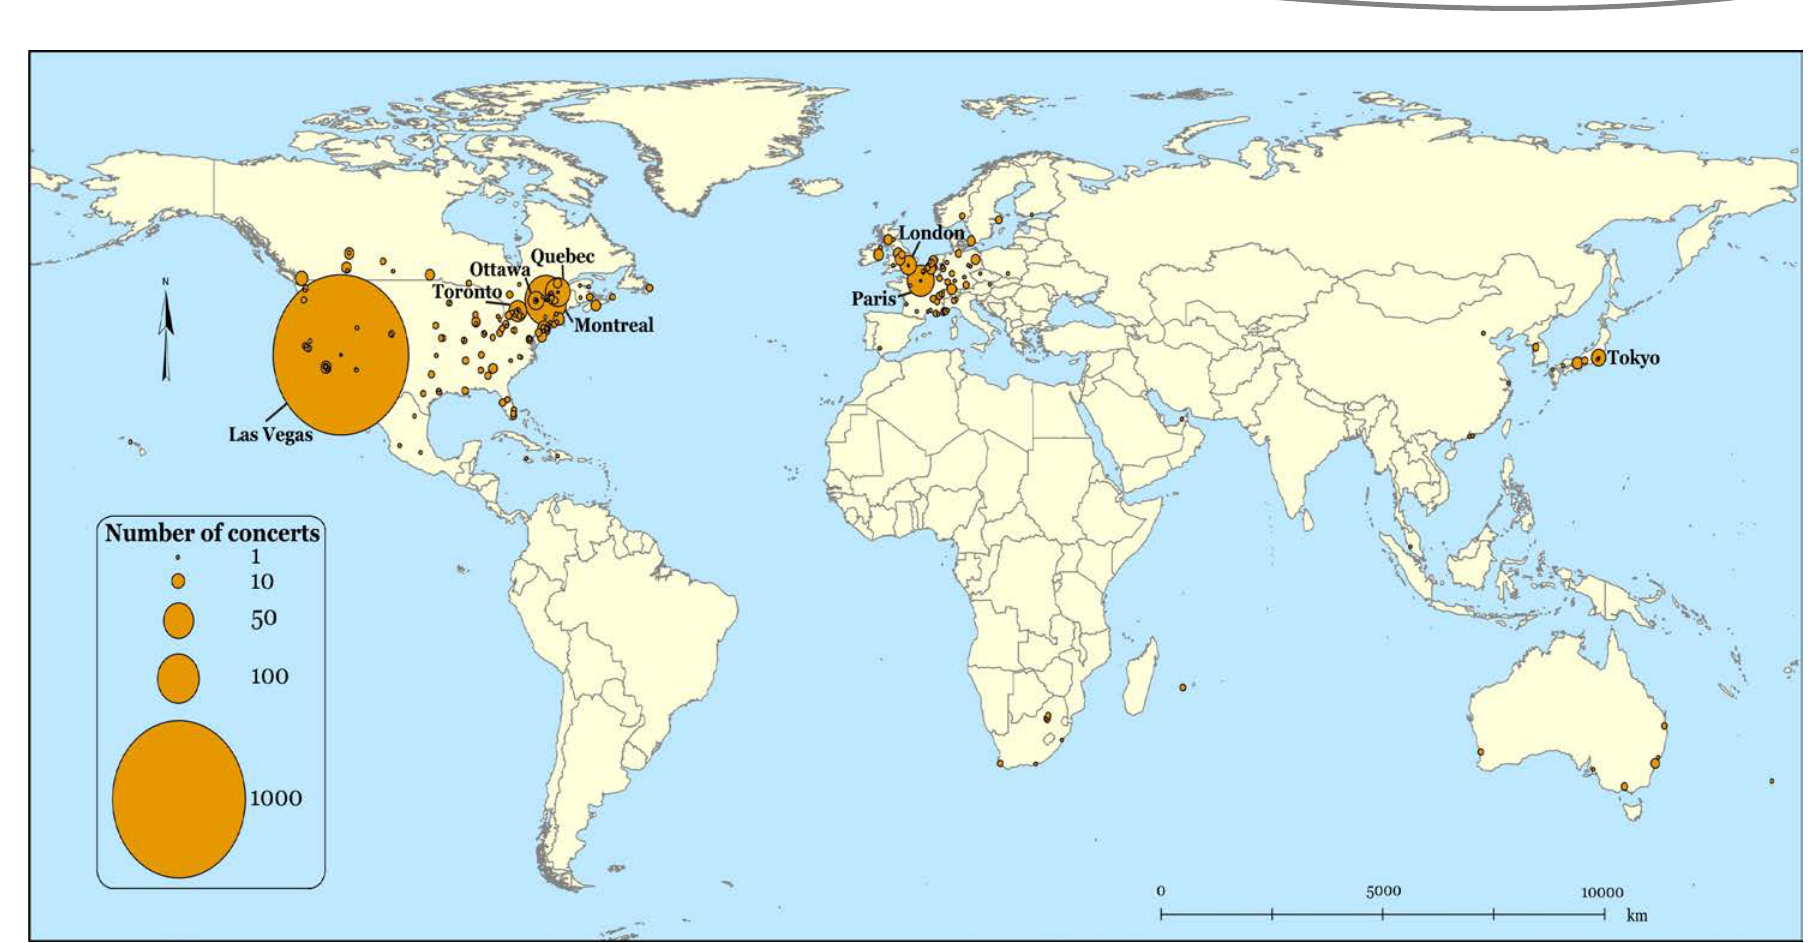
Figure 5: Cities as music scenes where Dion performed (1984 –